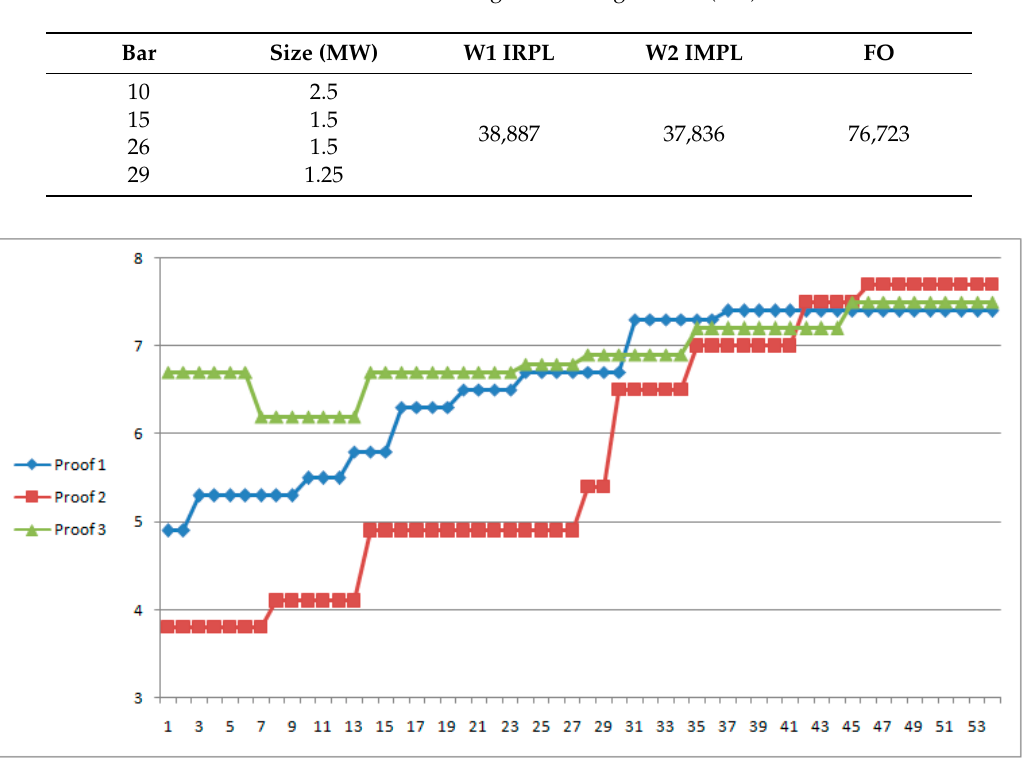
Table 5. Best result using Variable Search Environment Descending (VSED).